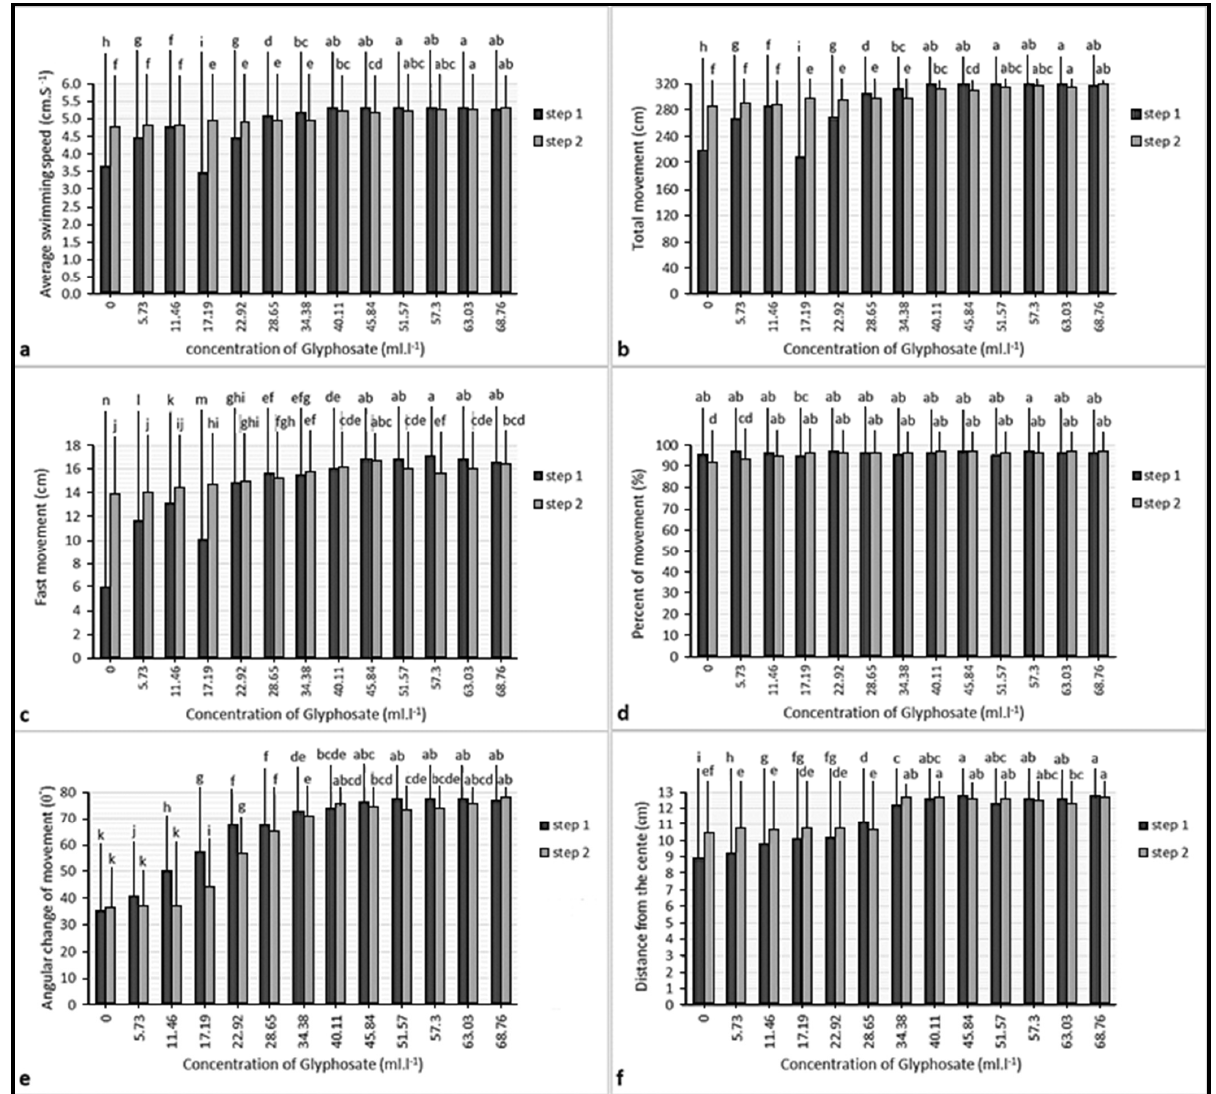
Figure 5. Parameters of swimming pattern of the fish in the control group: ( a ) average speed; ( b ) total movement; ( c ) fast movement; ( d ) percent of movement; ( e ) average angular change of movement; ( f ) distance from the center. Different lowercase letters (a, b, c and else) indicate significant differences between values of the same color columns ( p < 0.05).